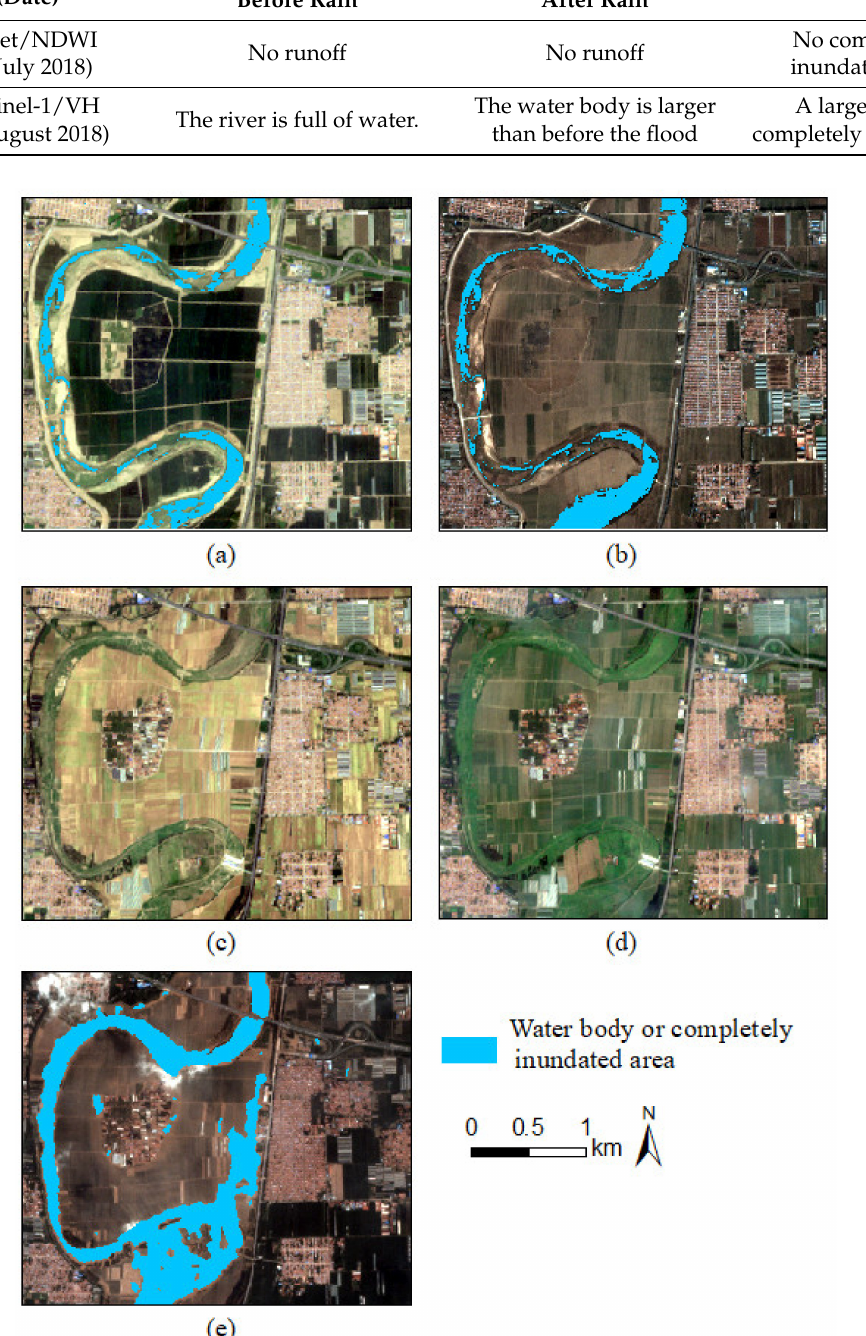
Figure 8. Distribution of water in each rainfall: ( a ) 5 May 2020 (date of base map: 6 May